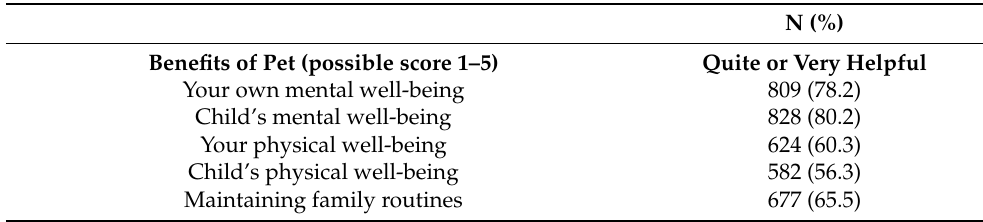
Table 1. Full sample item-level descriptives for perceived pet benefits, worries about pet, and pet-related activities (N =